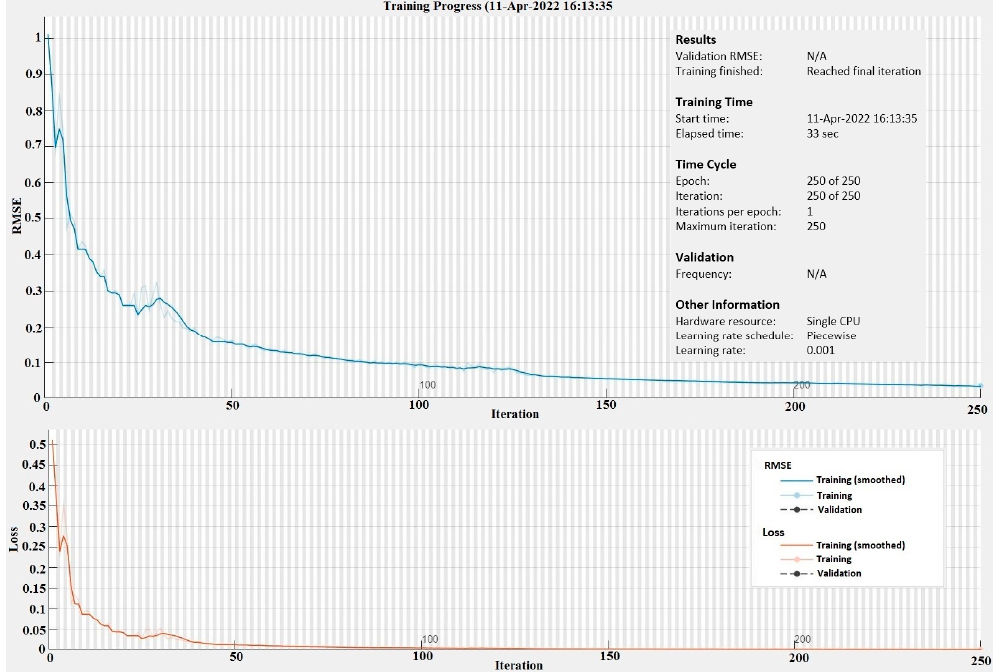
Figure 19. Training progress representation for per-week forecasting using LSTM-based DNN.